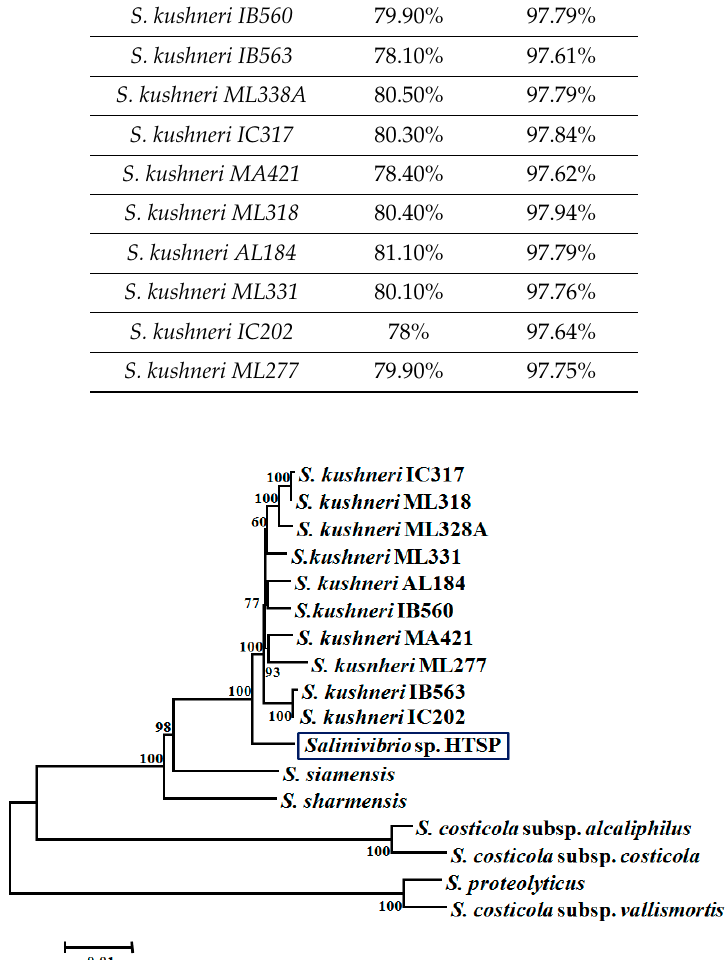
Figure 2. Core phylogenetic tree of Salinivibrio sp. HTSP and other 16 Salinvibrios sequenced by López-Hermoso et al. [9]. The tree was constructed based on the neighbour-joining distance from an alignment of 2267 core genes among all these genomes. The bootstrap test (1000 replicates) is shown